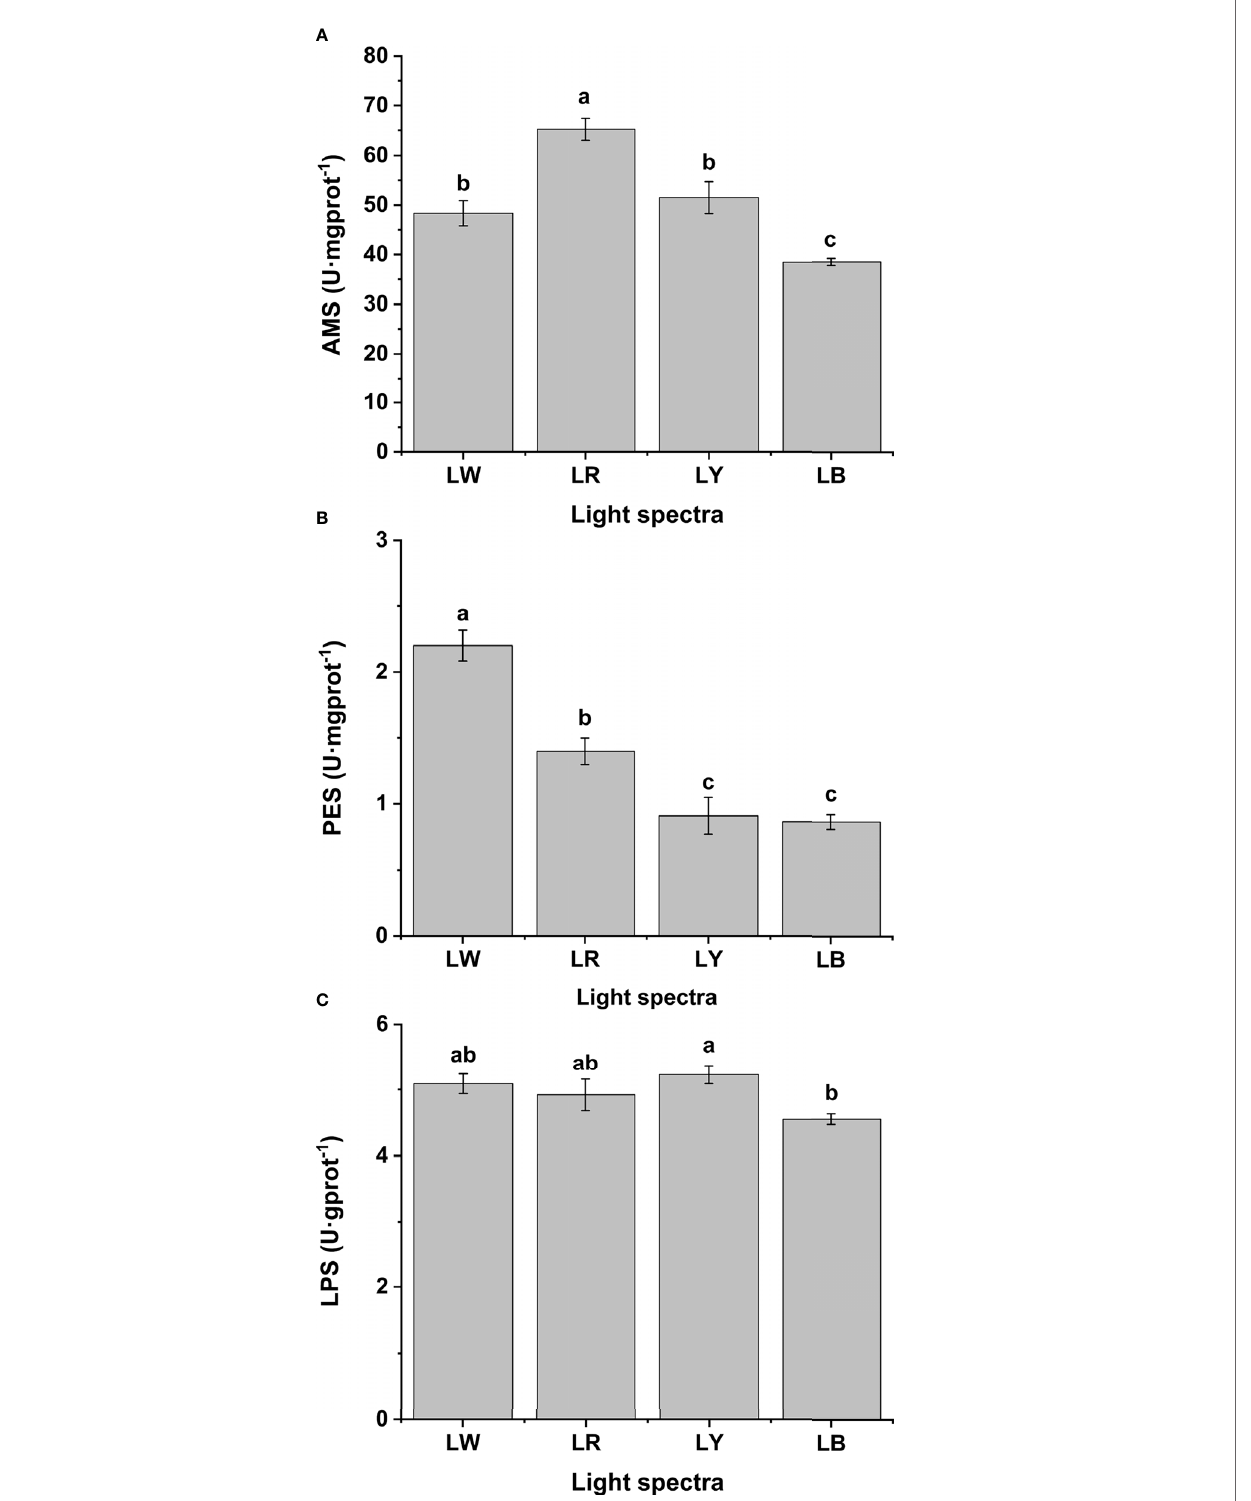
FIGURE 1 | Related digestive enzyme activities of GIFT tilapia juveniles cultured under different light spectra. (A) The a -amylase (AMS) activities of GIFT tilapia juveniles under four light spectra. (B) The protease (PES) activities of GIFT tilapia juveniles under four light spectra. (C) The lipase (LPS) activities of GIFT tilapia juveniles under four light spectra. Different letters implies statistical differences ( p <